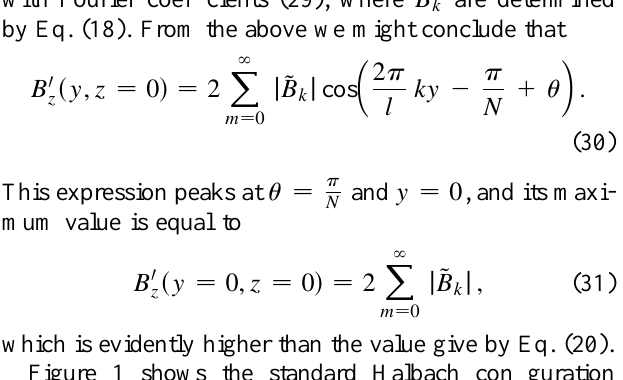
FIG. 4. Magnetic field produced by two different wiggler configurations—the Halbach and the rotated